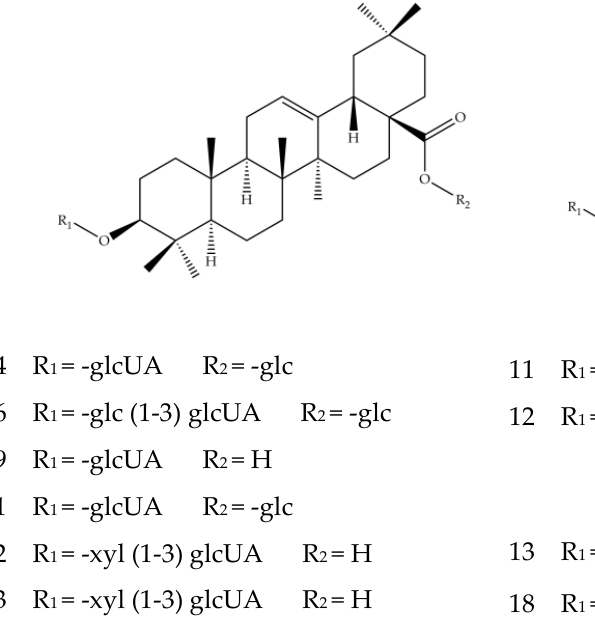
Figure 3. The structures of Compounds 1 – 5 and 8.